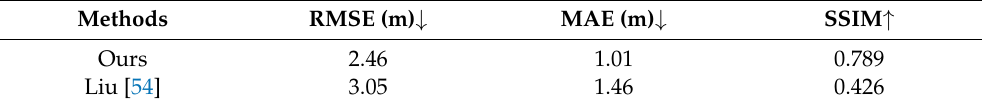
Table 3. Comparison of the results of current main methods in Dublin Dataset.